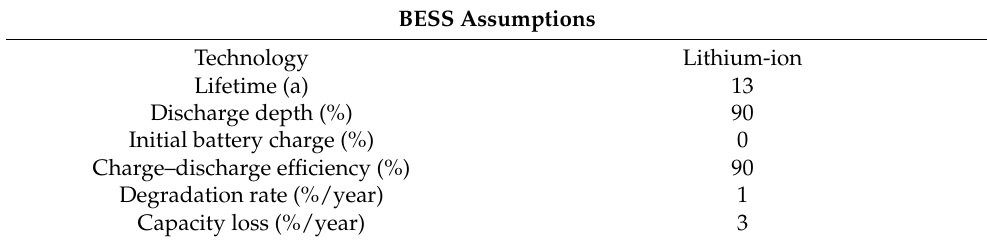
Table 2. Storage system parameters included in the simulation